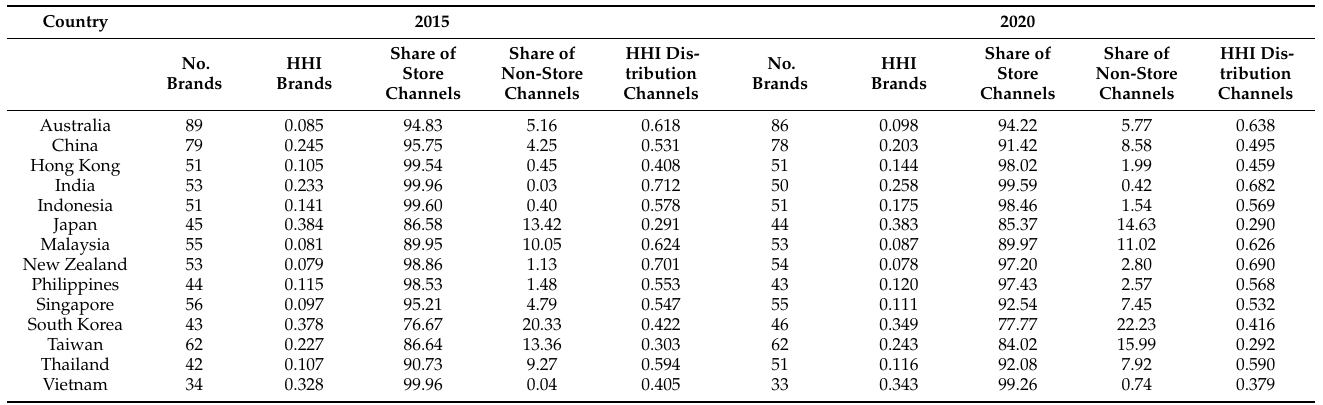
Table A4. Comparison in HHI of brands and distribution channels in the Asian market between 2015 and 2020.